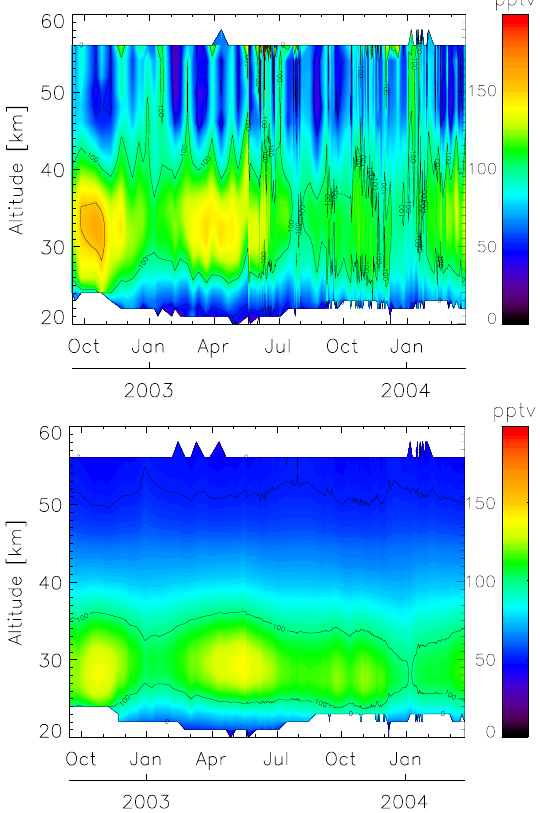
Fig. 9. Top: Timeseries of MIPAS H 2 O 2 daily zonal mean vmr aver- aged between 10 ◦ N and 10 ◦ S; Bottom: same for KASIMA results with MIPAS A applied